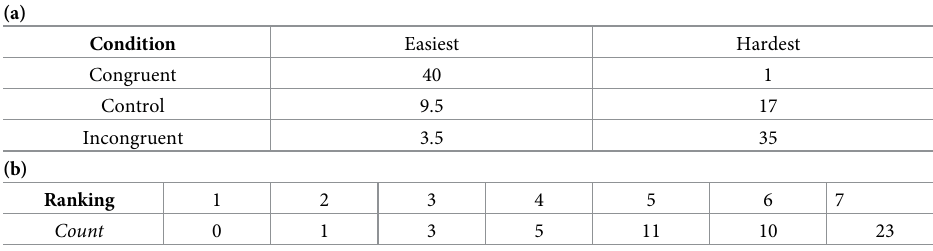
Table 2. Participants’ (n = 53) questionnaire results as derived from their answers to the questionnaire. (a) Diffi- culty Rankings. (b) Likert